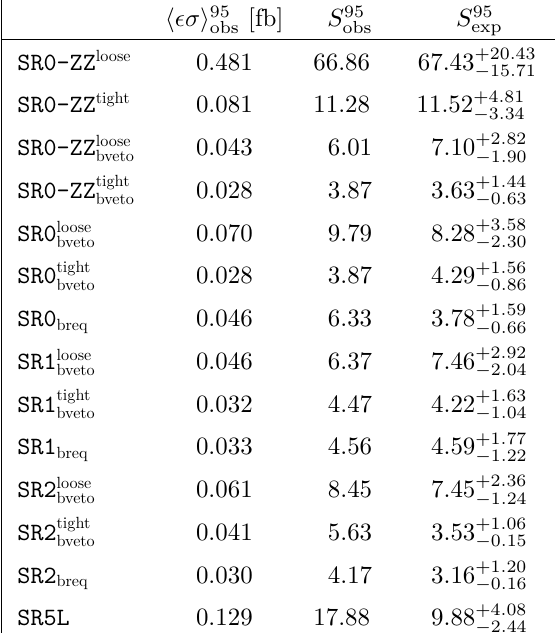
), the observed number of signal obs , ± 1 σ vari- exp